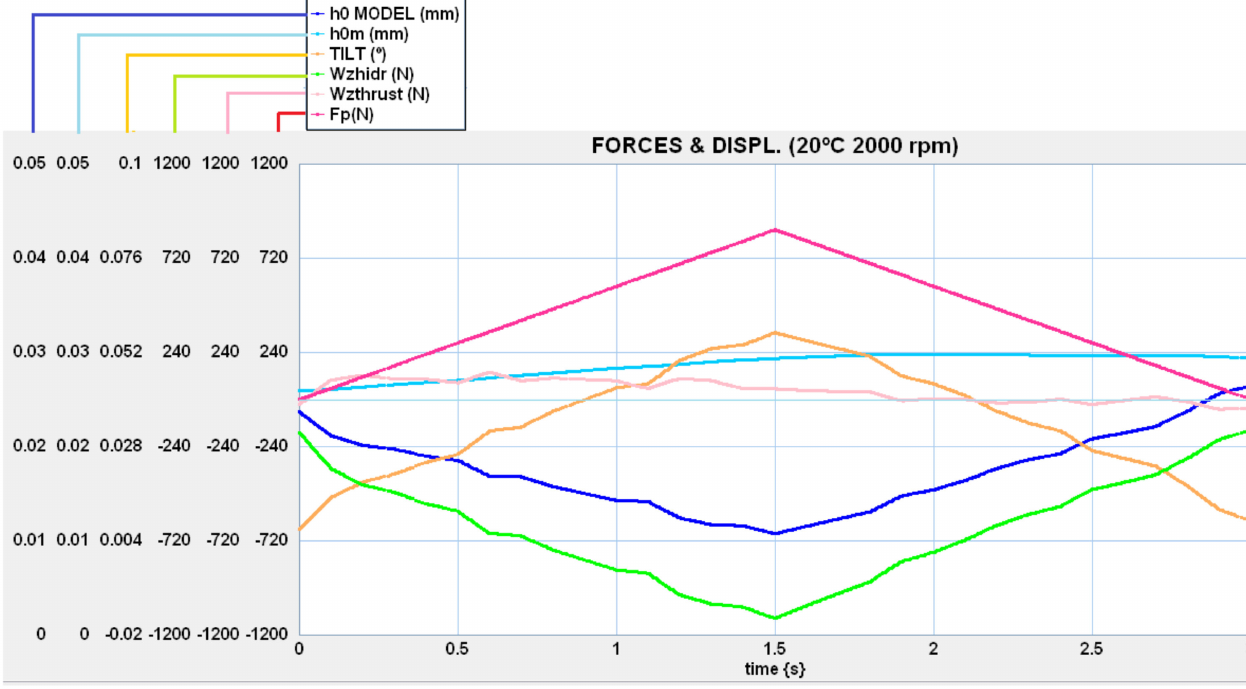
Figure 12. Balance of forces on the bushing and displacements (2000 rpm 20 ◦